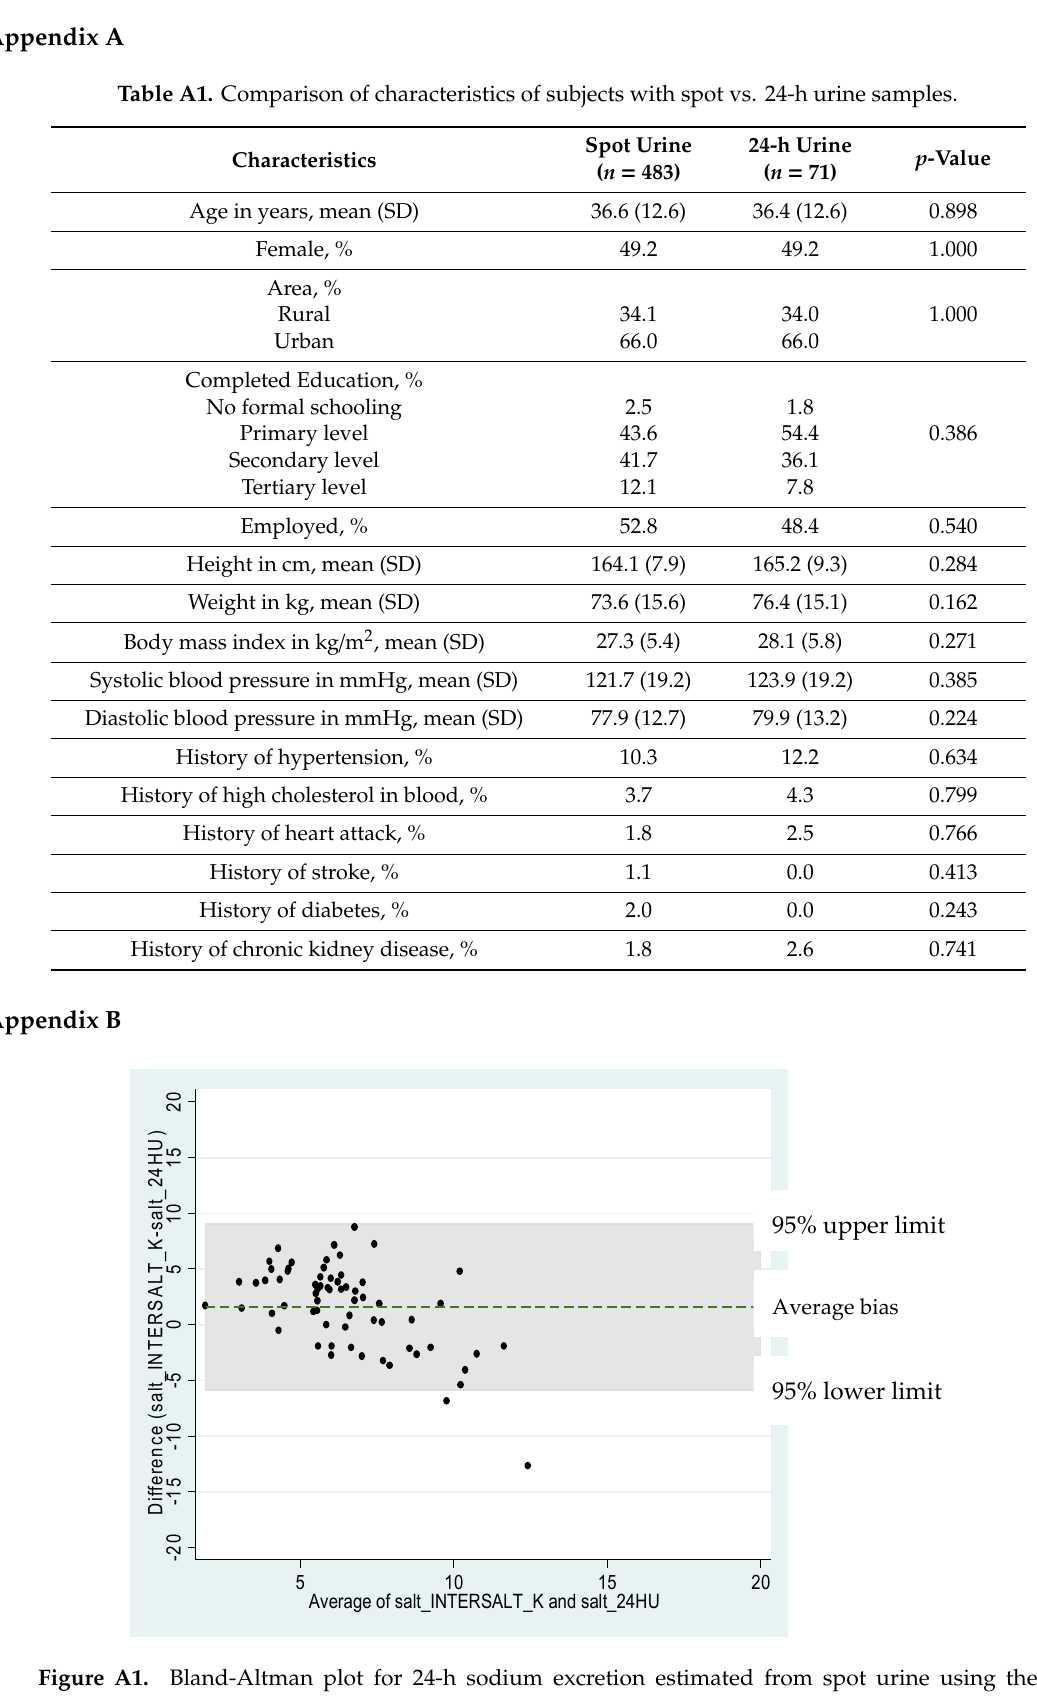
Figure A1. Bland-Altman plot for 24-h sodium excretion estimated from spot urine using the INTERSALT with K method.